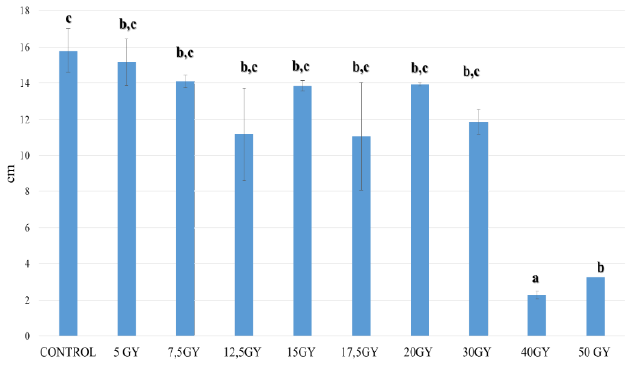
Figure 3. Height of the plants at different doses of radiation